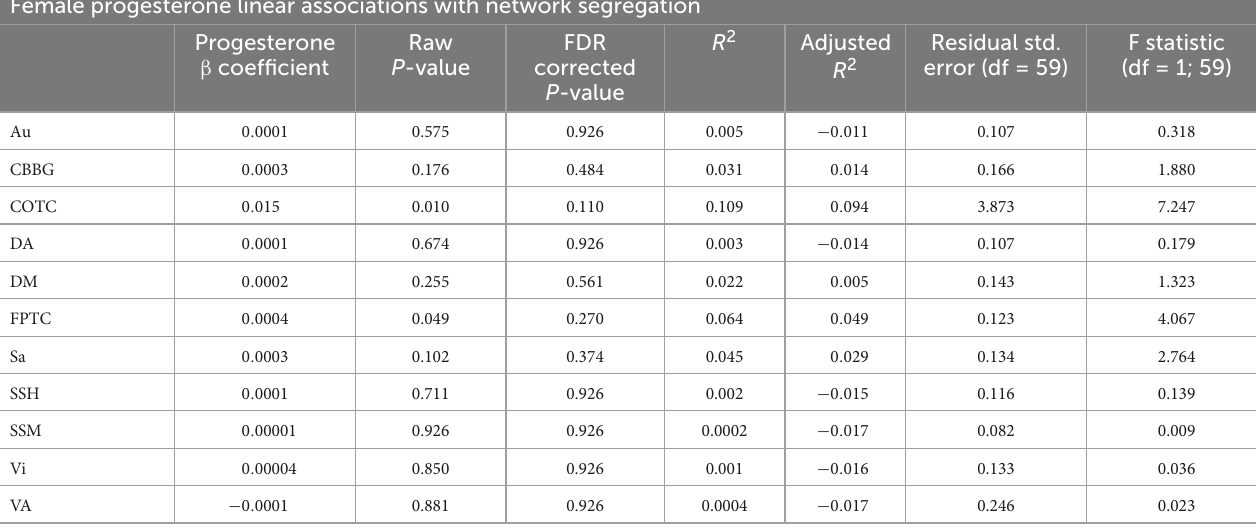
TABLE 3 This table presents results from linear regressions for progesterone and network segregation in females. Female progesterone linear associations with network segregation